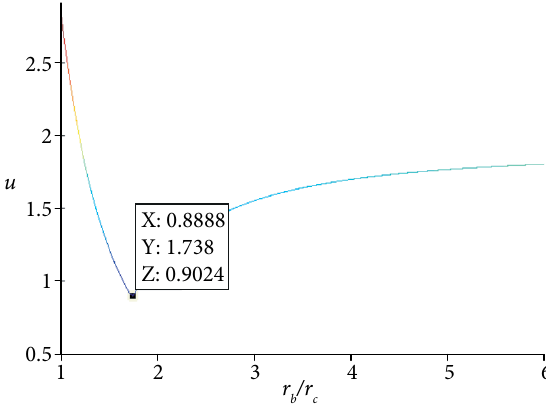
Figure 14. The relation between the parameters u and r